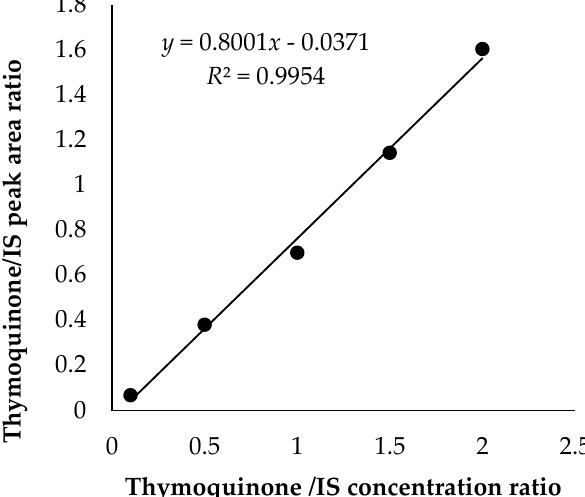
Figure 1. Calibration curve for quantitative determination of thymoquinone using thymol as internal standard (IS).